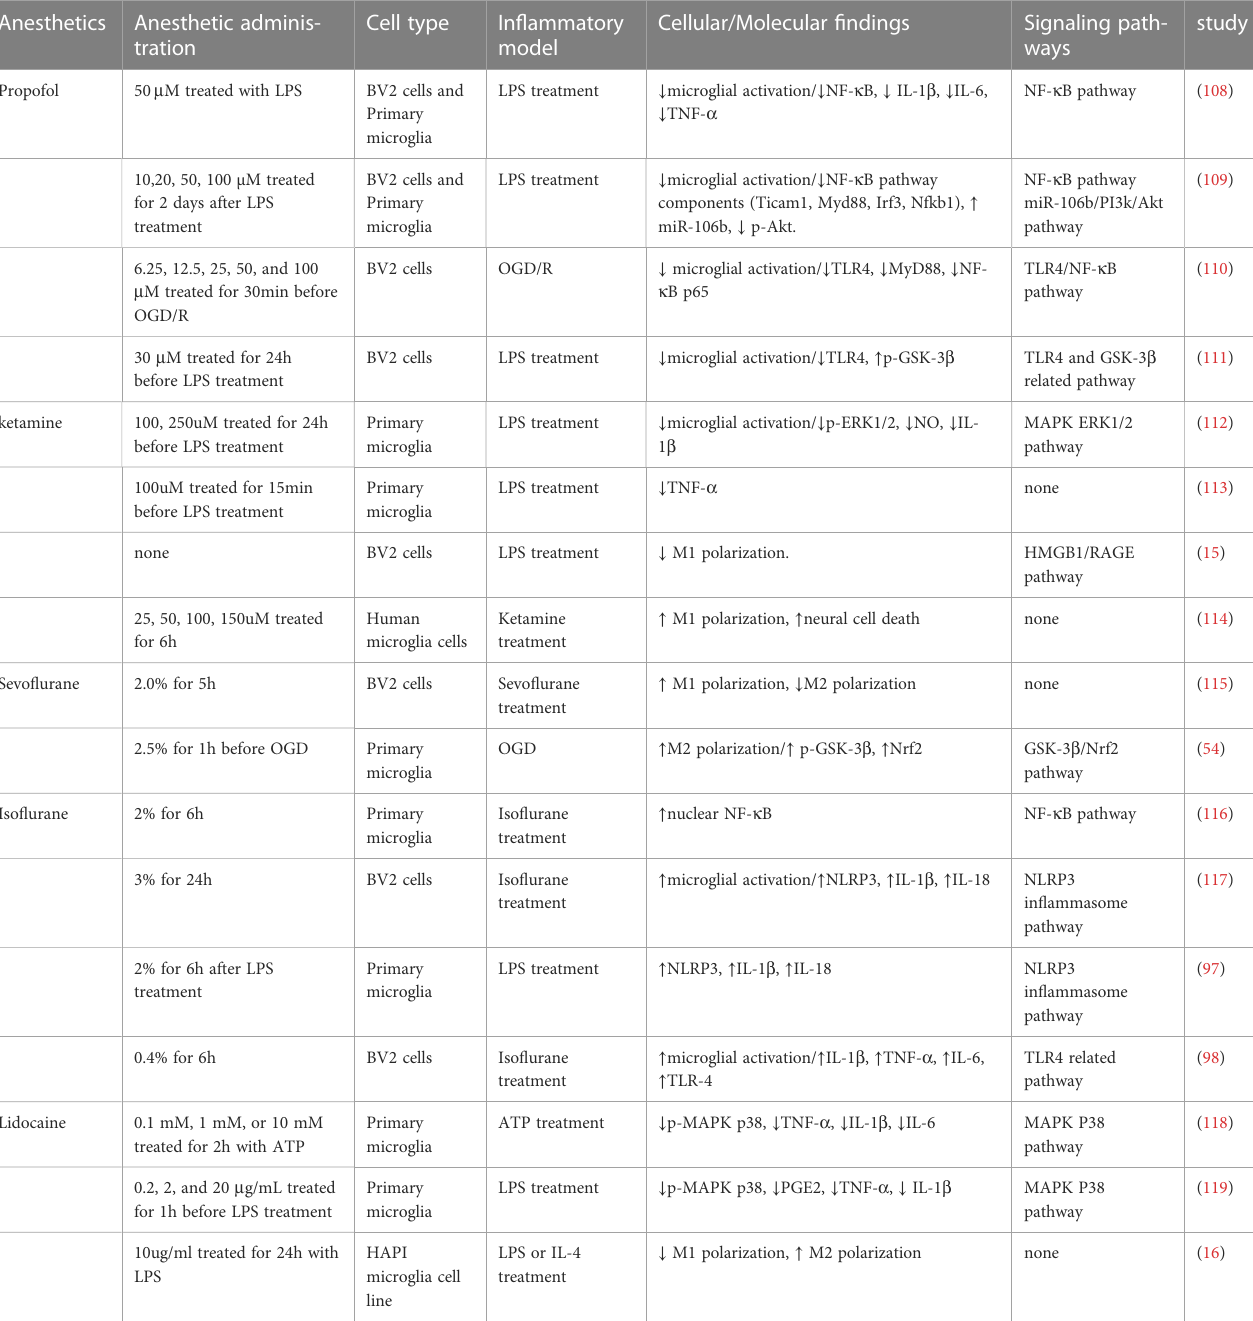
TABLE 2 Effects of anesthetics on microglia and related signaling pathways in vitro .